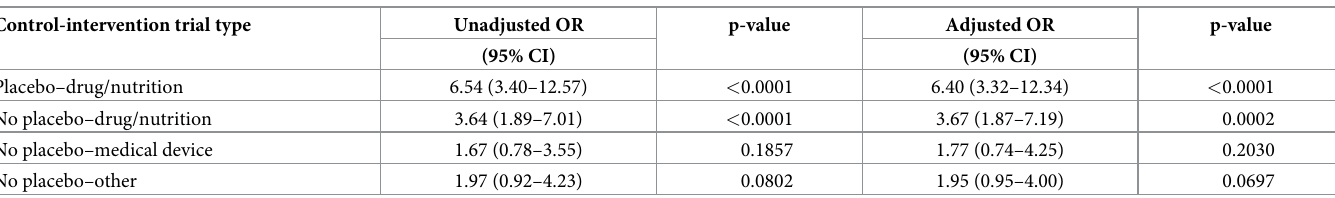
Table 4. Odds of consenting by trial type in LMIC versus HIC trials.